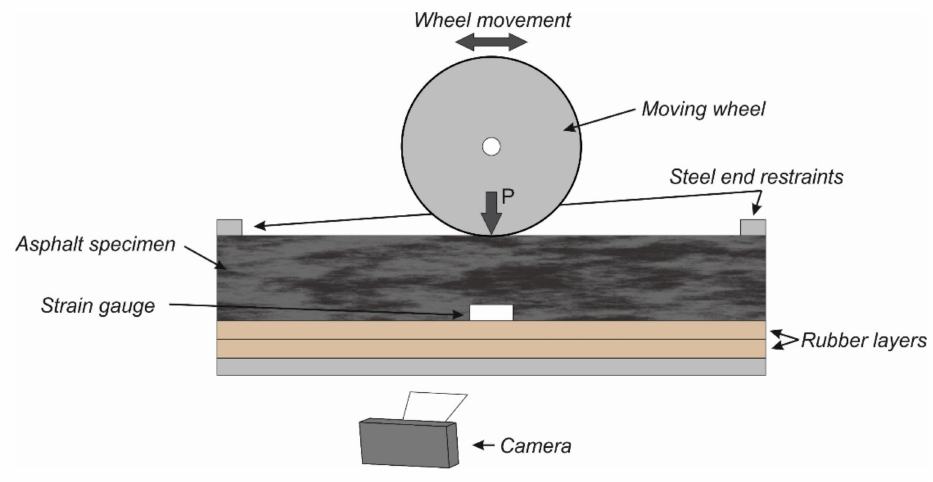
Figure 7. Scheme of experimental setup of BWTFT according to